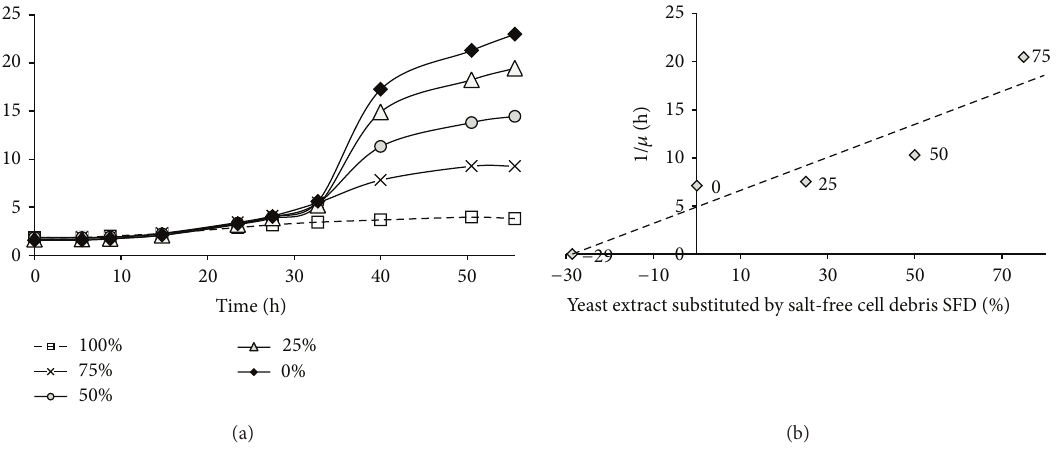
Figure 5: Cultivation of H. mediterranei DSM 1411. Time courses of OD 420 nitrogen and phosphate source yeast extract was not, partly, and totally substituted by desalinated cell debris